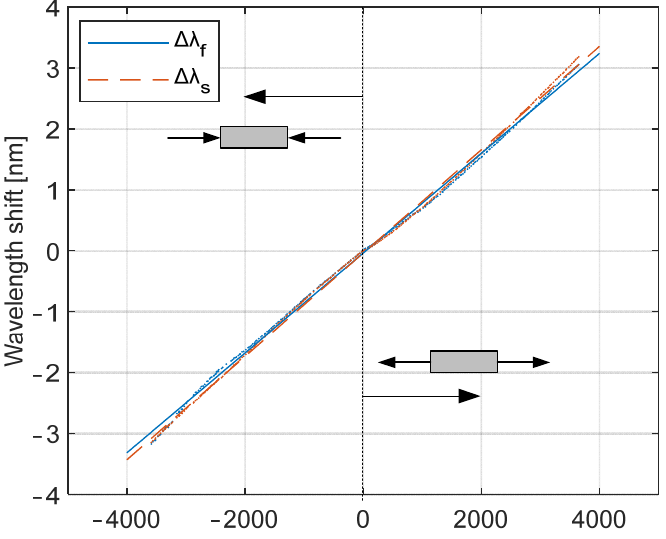
Figure 10. Bragg wavelengths shift of the FBG, when the strain was applied along the optical fiber. The linear regression of the Δλ(ε) resulted in R (cid:2870) > 0.99 for both axes. The stain sensitivities derived from the linear fits of measurement data were k (cid:2916) = 0.819 pm/με and k = 0.848 pm/με If the peak wavelength is determined with 1 pm resolution, then strain in this direction can be measured with 1.28 με resolution.